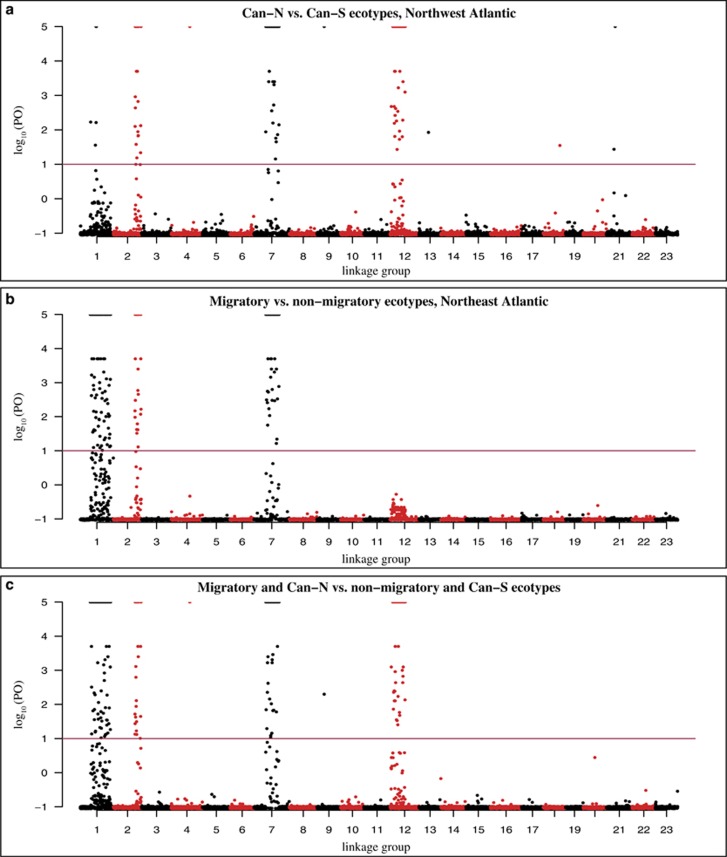
Manhattan plots visualizing the pairwise outlier patterns between ecotypes of Atlantic cod. The observed outlier pattern between Can-N and Can-S (a) indicates that the majority of outliers are clustered within the inversions in LGs 2, 7 and 12, whereas the inversions within LGs 1, 2 and 7 are putatively under selection between migratory and nonmigratory ecotypes in the Northeast Atlantic (b). By grouping all individuals into migratory and nonmigratory groups (see Table 1 for details), outliers are detected within the inversions in LGs 1, 2, 7 and 12 (c). The plots are based on median log10 posterior odds (PO) values from 10 independent runs of BAYESCAN. SNPs are plotted according to linkage group and position within the linkage groups along the x axis as in Berg et al. (2016). The red line at 1 indicates ‘strong association’ according to Jeffreys (1961). The migratory group consists of Can-N_PB (Placentia Bay), Can-N_SG (Southern Gulf of St Lawrence), Ice_F (Iceland Frontal) and NEAC (Northeast Arctic cod), whereas the nonmigratory group consists of Can-S_SB (Sambro), Can-S_GM (Gulf of Maine), Can-S_BB (Browns Bank), Ice_C (Iceland Coastal) and NCC (Norwegian coastal cod). For visualization purposes, maximum log10 (PO) values are set to 5 (all underlying values are found in Supplementary Table S3).